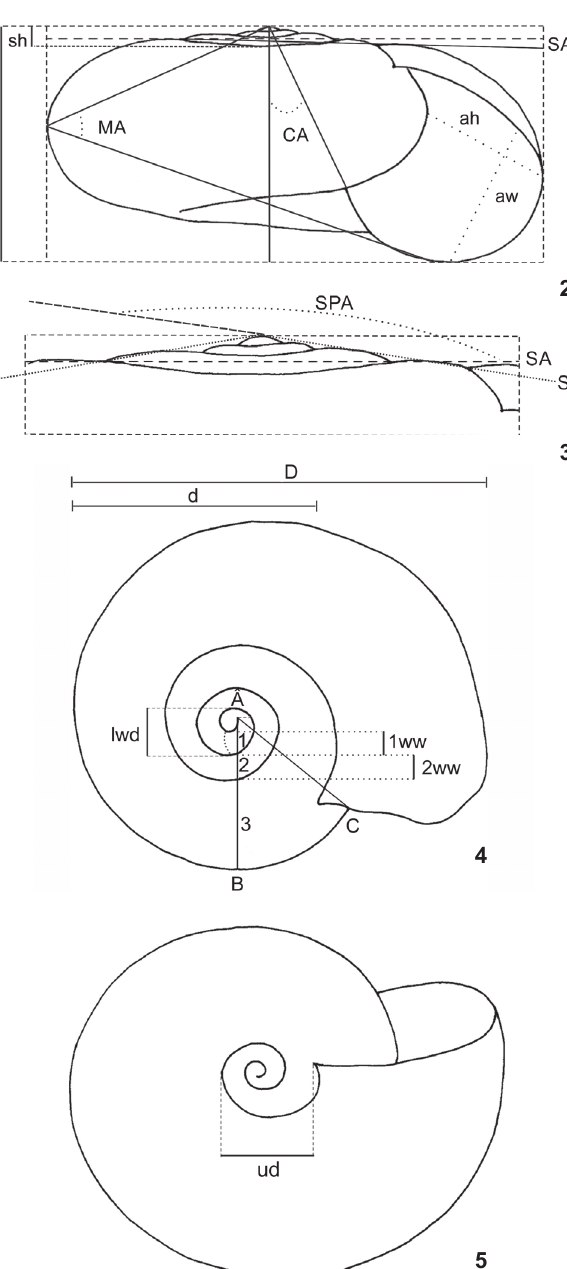
Figures 2-5. Happiella cf. insularis . Schematic depiction of shell, with angular, linear measurements, and number of whole whorls: (2) CA, columellar angle; MA, maximum angle; ah, aperture height; SA, sutural angle; sh, spire height; aw, aperture width. (3) SPA, spire angle; SA, sutural angle; SS’, lower sutural angle. (4) D = maximum diameter; d, smaller diameter; 1ww, first whorl width; 2ww, second whorl width; 1wd, first whorl diameter; 1, 2, 3, num- ber of whole whorls. (5) umbilical view: ud, umbilical